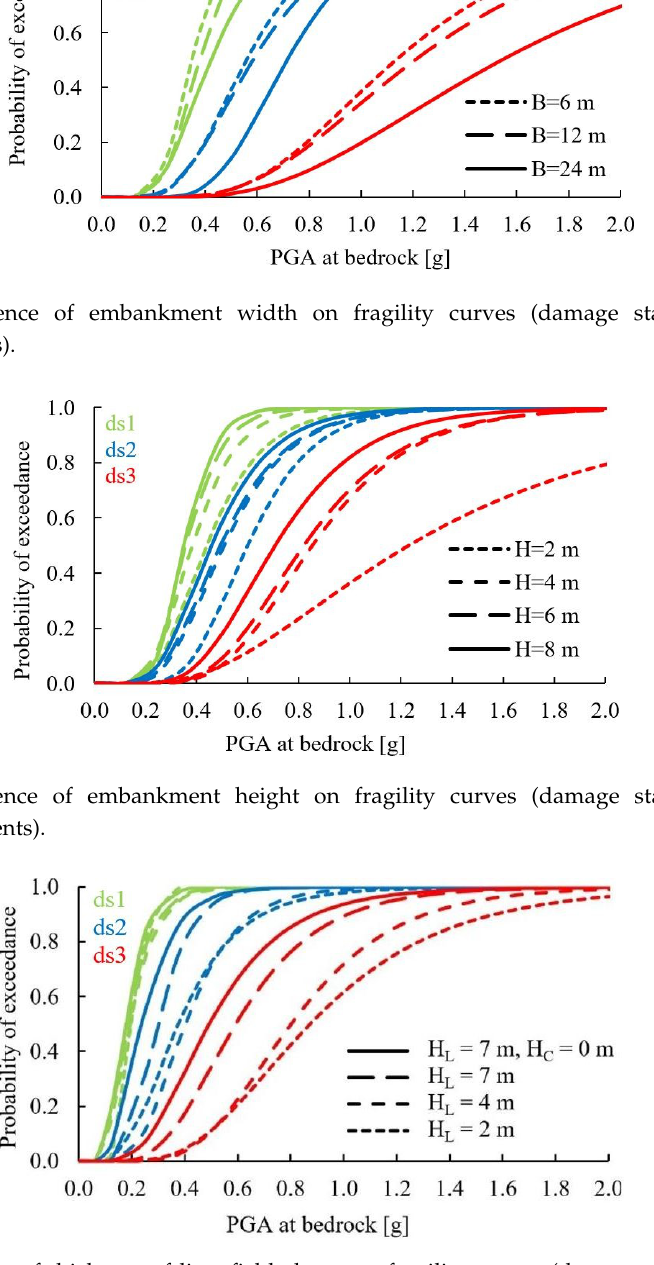
Figure 9. Influence of thickness of liquefiable layer on fragility curves (damage state criteria for road embankments).